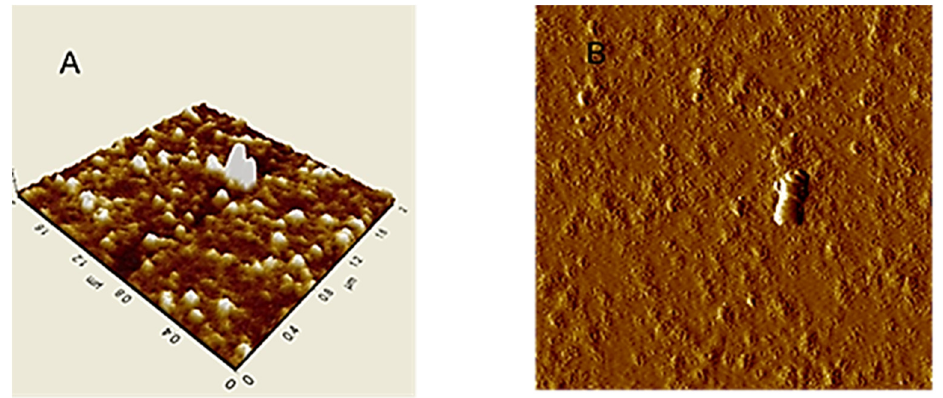
Figure 2. AFM images in tapping mode of Leonardite dispersed in water and then adsorbed and dried on mica surface: ( A ) Typical rounded particles; ( B ) Isolated particle cluster.